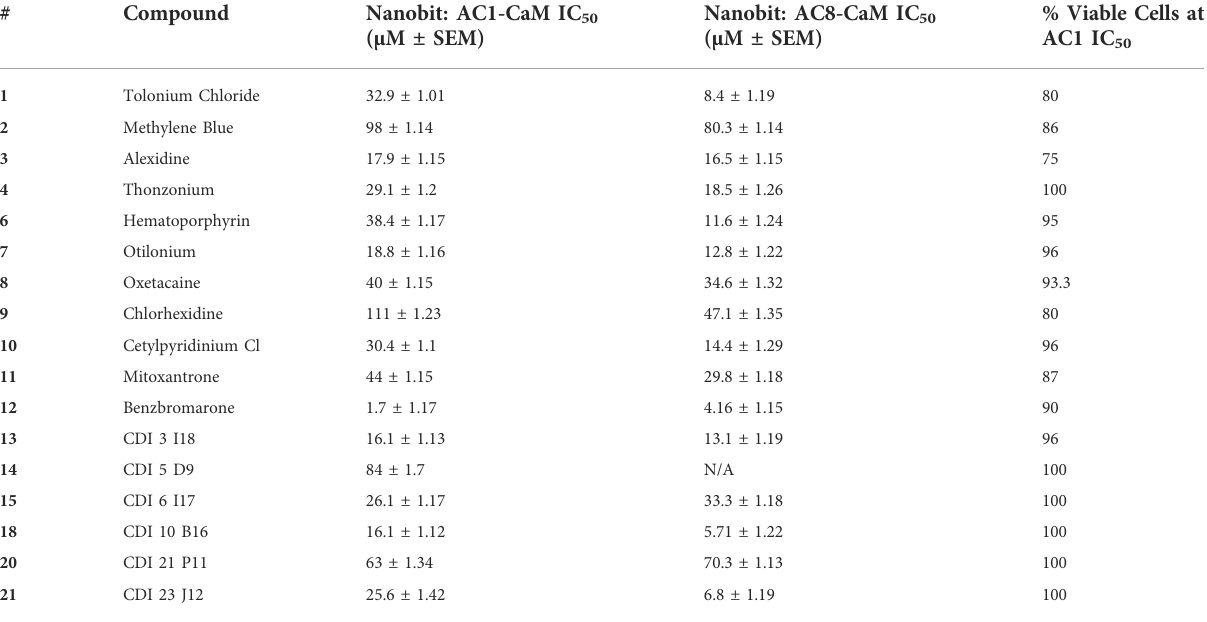
TABLE4ResultsforAC1/CaMpilotscreenhitsintheNanoBiTandcellviabilityassay.DataarereportedasIC 50 valueswithstandarderrorofthemean for the AC1/CaM and AC8/CaM NanoBiT assays. All data represent the average ±SEM of three individual experiments The fi nal column shows the % cell viability in the presence of each compound at it is AC1/CaM NanoBiT IC 50 concentration, using the CellTiter Glo-2.0 cell viability assay as previously described. All data represent the average ±SEM of three individual